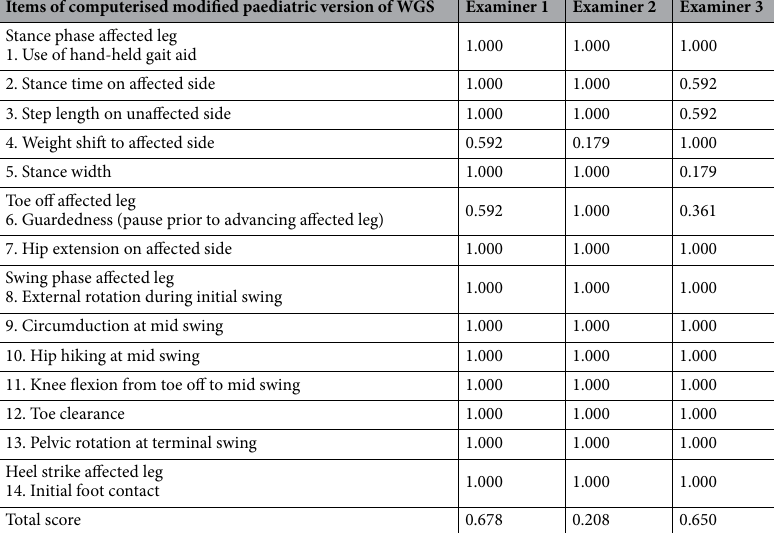
Table 5. Differences in assessment of the specific participants by the same examiner in measurement 1 and 2. p—Probability index in Wilcoxon signed-rank test.